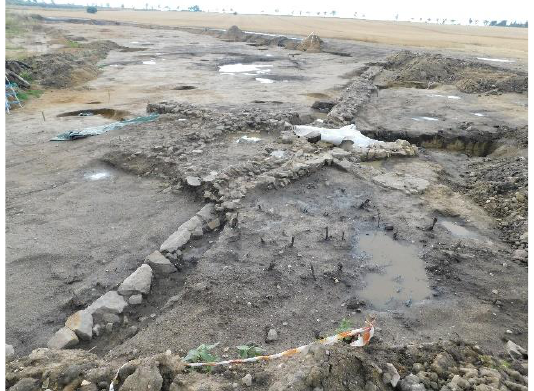
Figure 2. Praha – Dubeč. Mediaeval building of deserted village Litožnice on the bottom of the